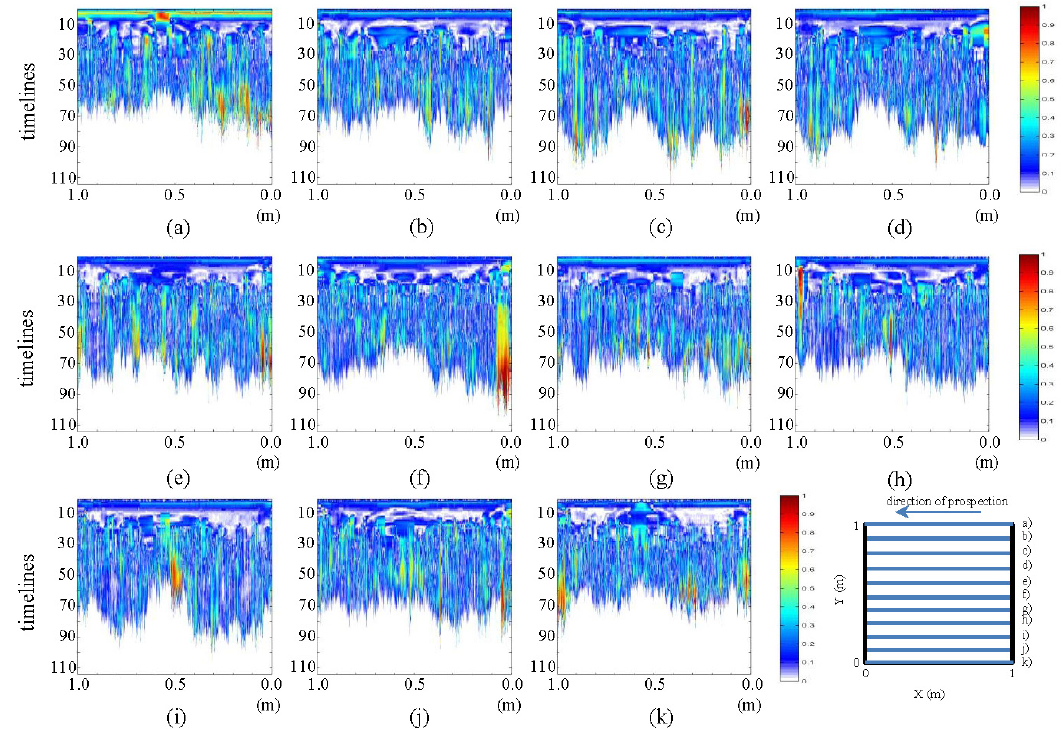
Figure 17. Horizontal profiles: contrast between pre-processed images. ( a – k ) are profiles s1 to s11, respectively.